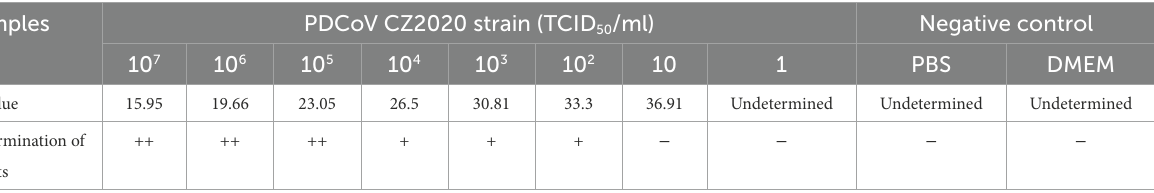
TABLE 2 Sensitivity of the qPCR for detecting PDCoV.